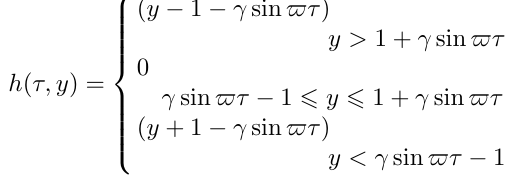
Fig. 8. The Poincare sections of the dynamic model with a time-varying clearance at (cid:4) = 1 . 1 and γ = 0 . 5